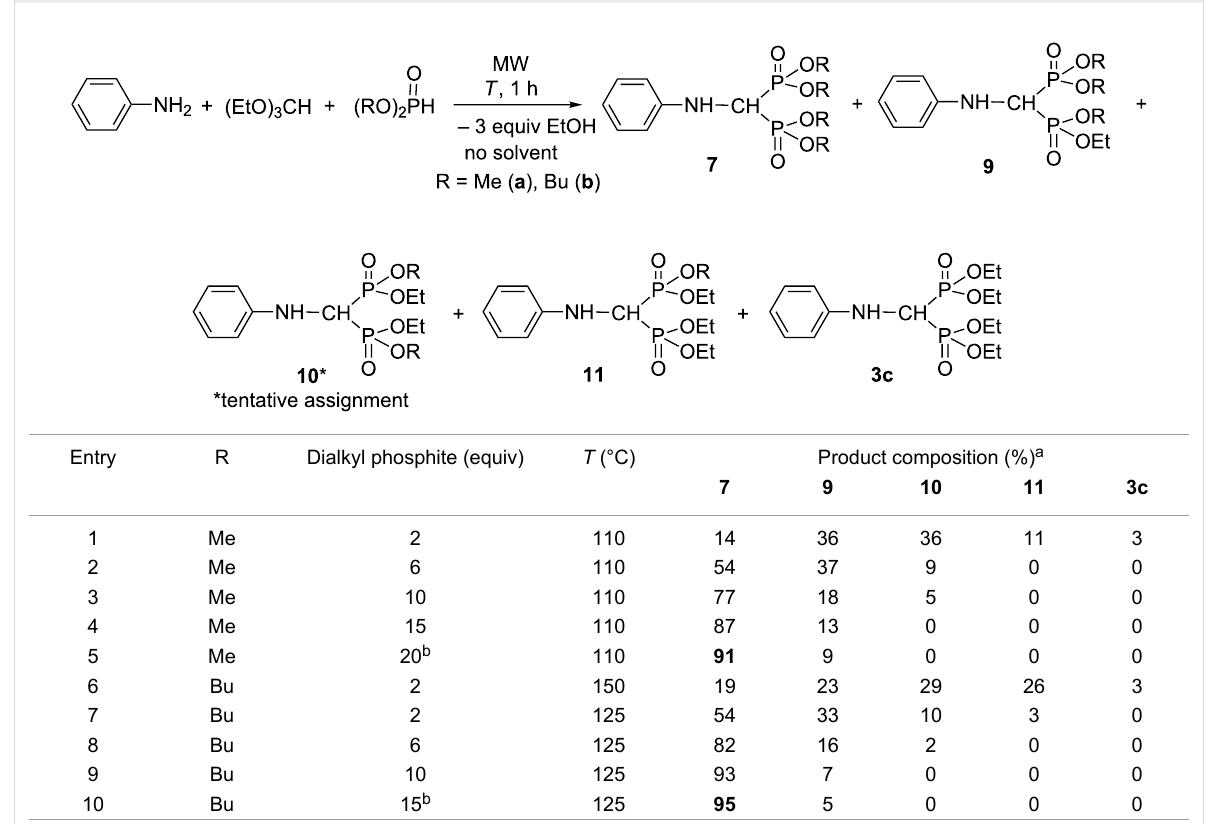
Table 6: Condensation of aniline, triethyl orthoformate and dimethyl or dibutyl phosphite.